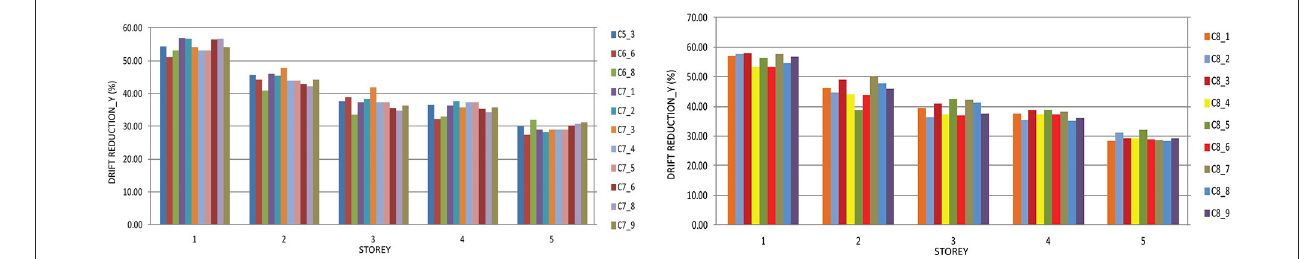
FIGURE 17 | Reduction of the inter story drifts in the case of the structure with the optimal solutions from the fifth, sixth and seventh cycle compared with the structure without dampers in Y direction.